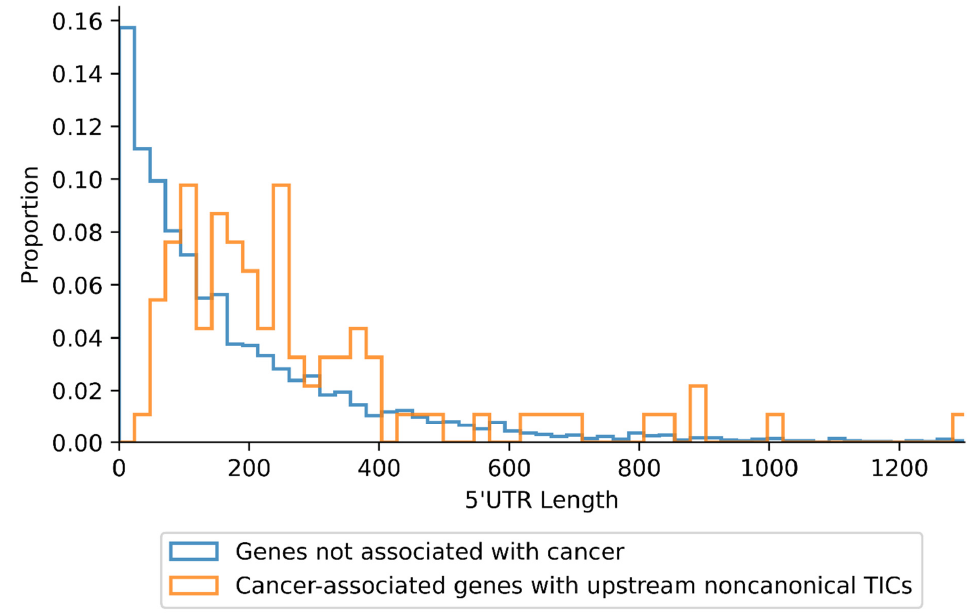
Figure 5. The length of the 5 ′ UTR in genes that are not associated with cancer as well as in cancer- associated genes with upstream noncanonical TICs.